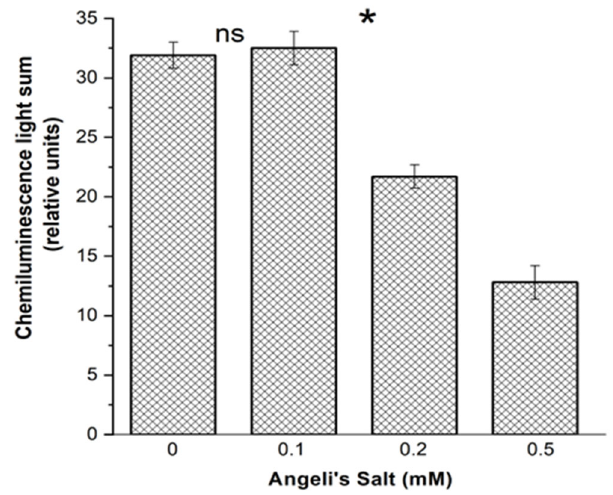
Figure 8. Effect of Angeli’s salt on the formation of free radical intermediates in the reaction of metHb ‐ H 2 O with t ‐ BOOH, measured with luminol ‐ dependent chemiluminescence. Reaction mixture: 0.15 mM Hb, 2 mM luminol, 0.6 mM t ‐ BOOH in 50 mM PBS (pH 7.4). Preparation of protein samples as in Figure 5. Results are depicted as the mean with S.E.M. of three independent experiments ( n = 3). One ‐ way ANOVA (* p ≤ 0.05; ns: non ‐ significant).